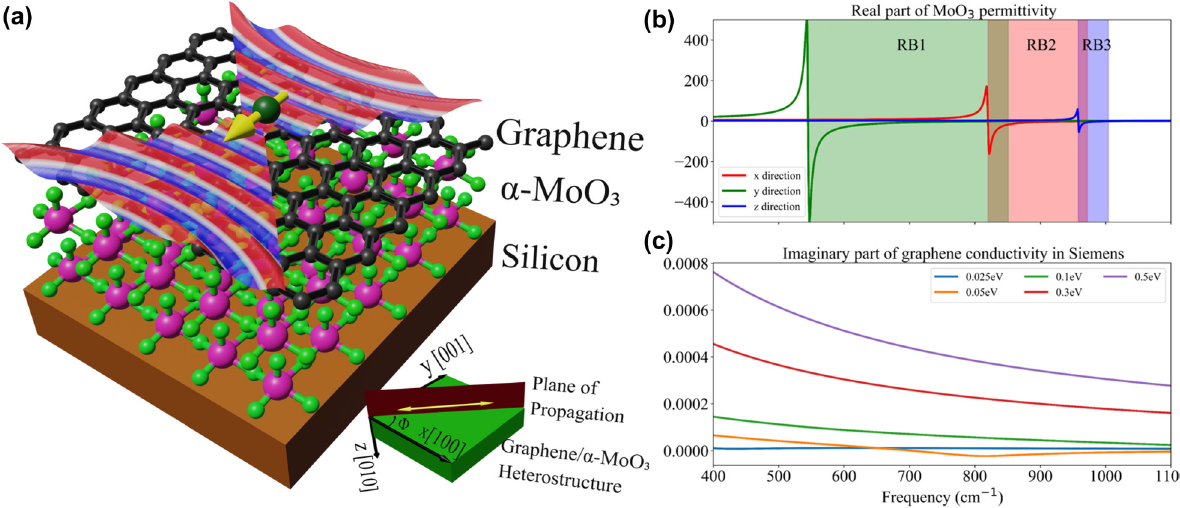
Figure 1: (a) Schematic representation of α -MoO 3 and graphene heterostructure on silicon substrate exhibiting the hybrid plasmon-phonon polariton modes propagation at the surface. Inset: crystallographic direction of α -MoO 3 and ϕ – angle between plane of propagation of light and x -axisofthe α -MoO 3 .(b)Realcomponentofdielectricpermittivityof α -MoO 3 alongtheprincipaldirections.(c)Imaginarycomponentof2D in-plane conductivities for varying chemical potential in